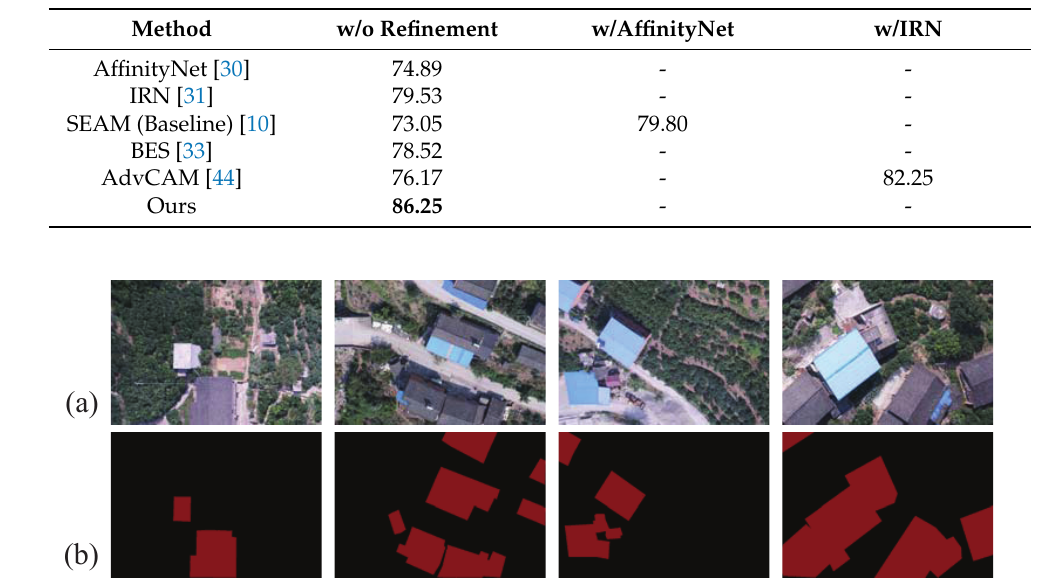
Table 5. Accuracy ( mIoU %) of pseudo-labels evaluated on the Majiagou training set. The best score is shown in bold throughout all experiments.